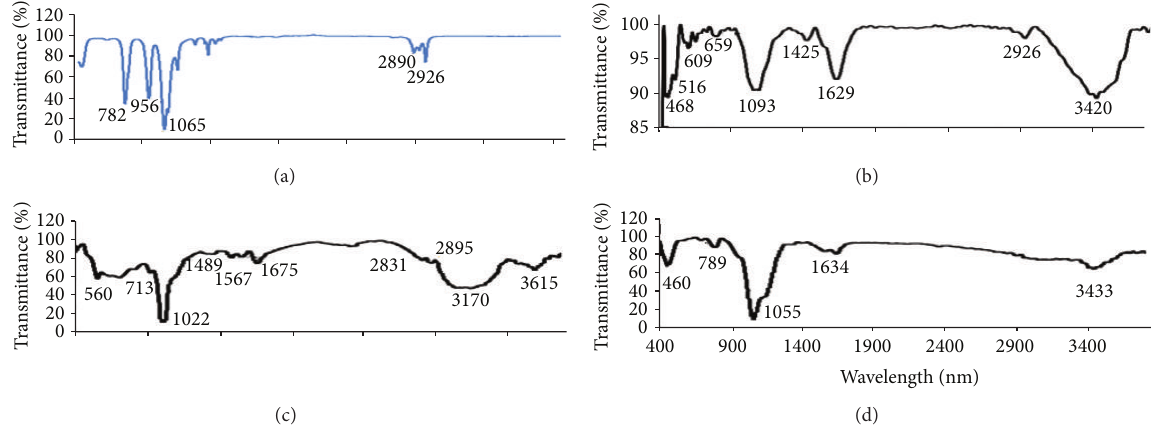
Figure 4: FTIR Spectrum of (a) TEOS, (b) silica, (c) fluorescent silica and (d) surface modified silica nanoparticles.